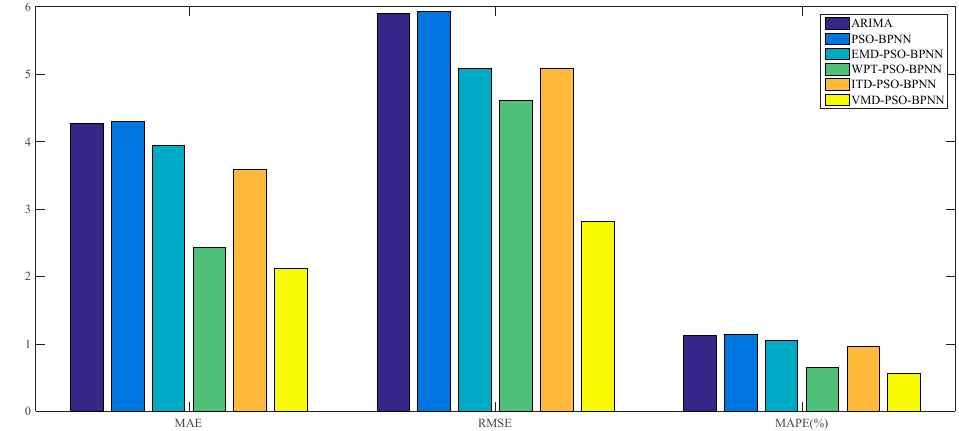
Figure 18. Error graphics of different models of corn. Table 4. Forecasting performance evaluation of corn.